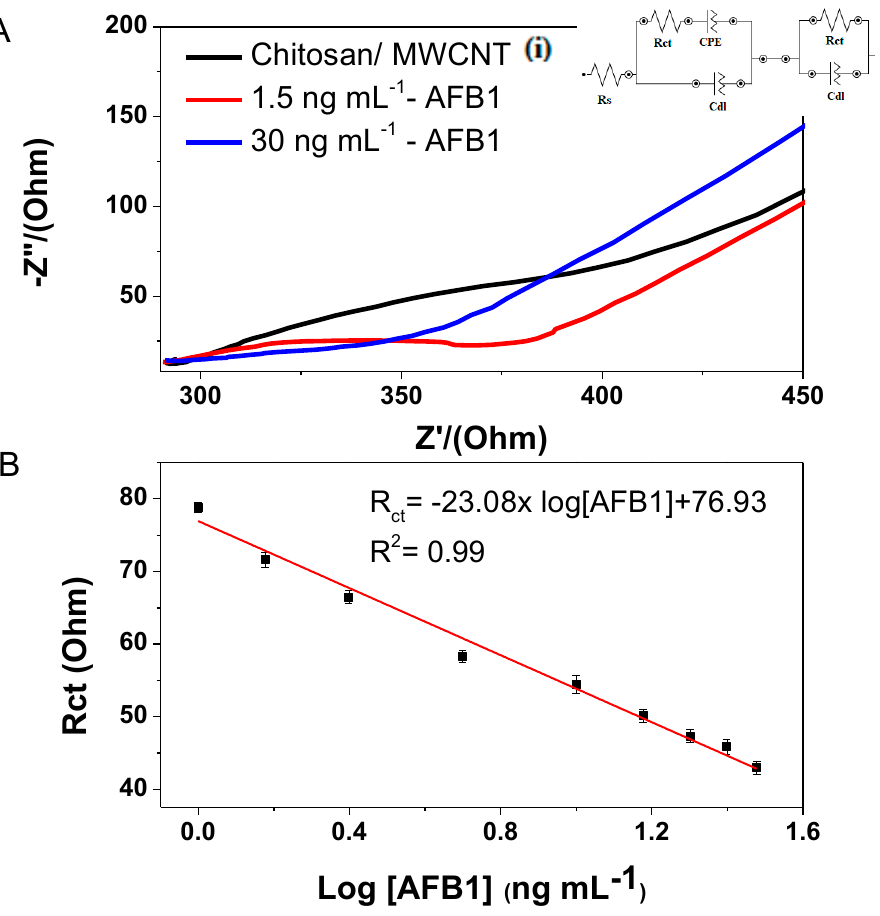
Figure 5. ( A ) Electrochemical impedance measurements for the electrode modified with chitosan/MWCNT films and with the anti-AFB1 immobilized after the antibody/antigen incubation time with different concentrations of AFB1. The inset (i) shows the equivalent circuit model used to fit and analyze the impedance data. ( B ) Rct × logarithm of AFB1 concentration from 1 to 30 ng mL − 1 .